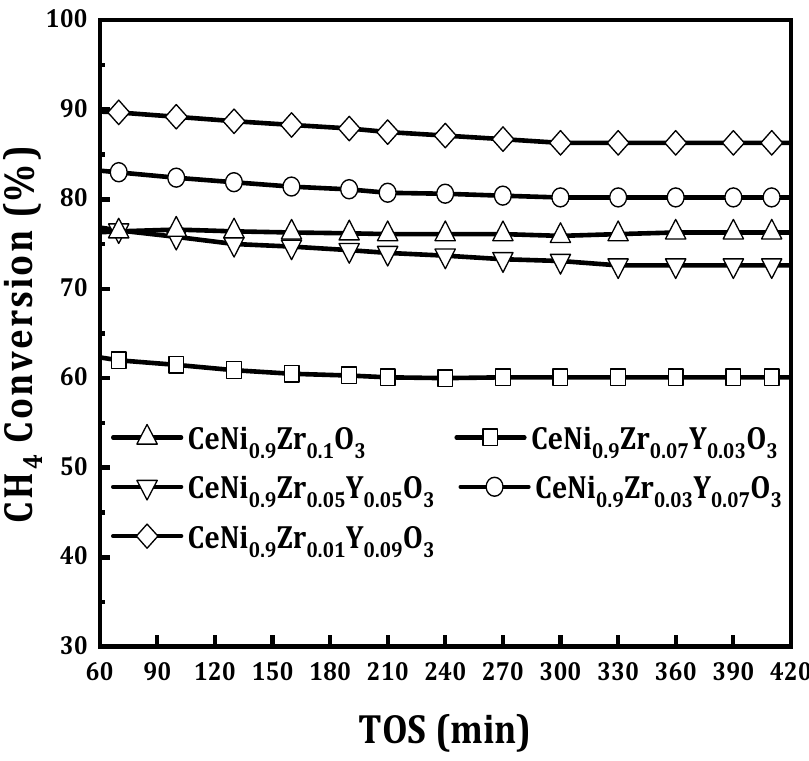
Figure 8. CH 4 conversion of perovskite catalysts CeNi 0.9 Zr 0 . 1 − x Y x O 3 (x = 0, 0.03, 0.05, 0.07, and 0.09) at 800 °C, 1 atmosphere and GHSV = 42 L/(h.g cat ).